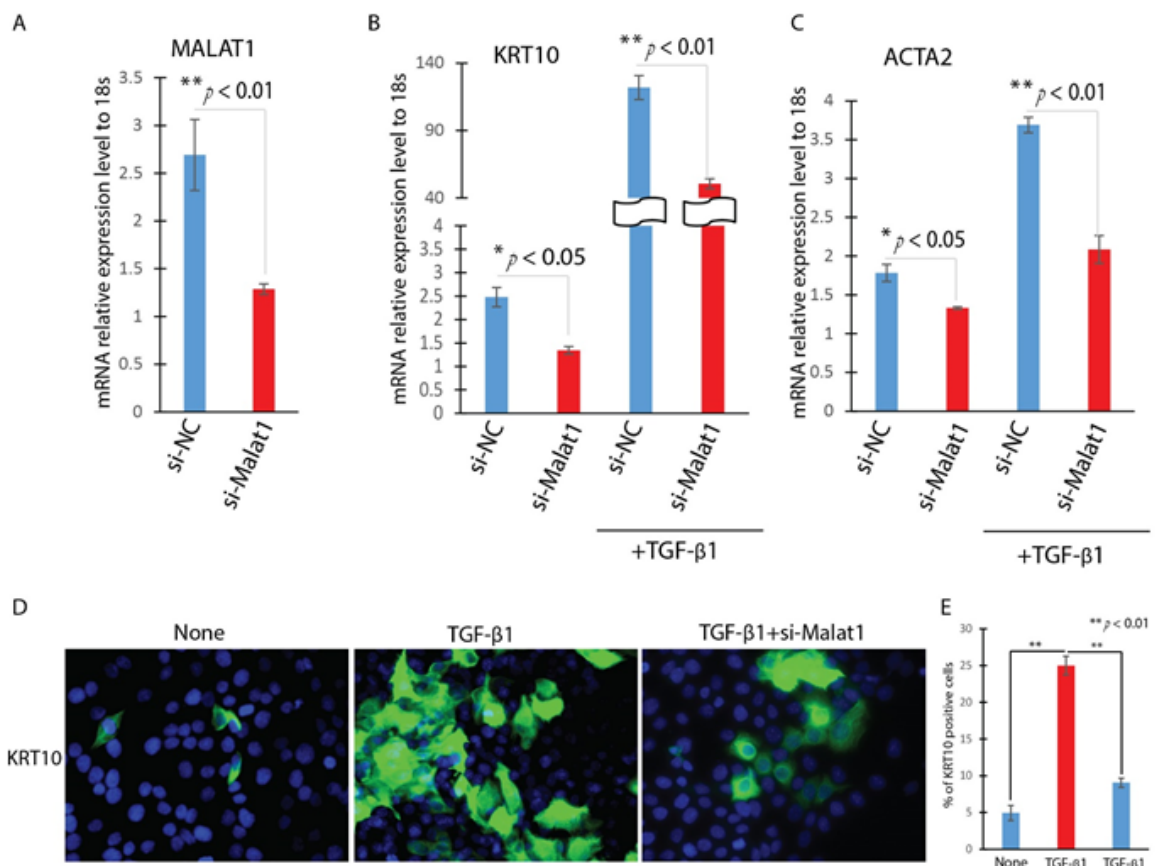
Figure 3. Knockdown of MALAT1 attenuates the TGF- β 1 induced EMT in HaCat cells. HaCaT cells were transfected with MALAT1 SiRNA (Si-MALAT1) or negative control SiRNA (Si-NC) and were treated with or without TGF- β 1 (2 ng/mL) for 24 h. ( A ). The expression levels of MALAT1 were detected by Realtime qPCR. n = 3; mean ± SD; * p < 0.05, ** p < 0.01 compared between si-Malat1 and si-NC transfected HaCaT cells. ( B , C ). The expression level of EMT-related markers (KRT10 and ACTA2) were detected by Realtime qPCR. ( D ). The expression of KRT10 were detected by immunofluorescence. ( E ). Quantitative analysis of number of KRT10 positive (KRT10 staining) per 20 × field. Comparison was performed between PBS, and TGF- β 1 treated, or TGF- β 1 treated and TGF- β 1 treated with si-MALAT1. n = 5; mean ± SD; * p < 0.05, ** p < 0.01.